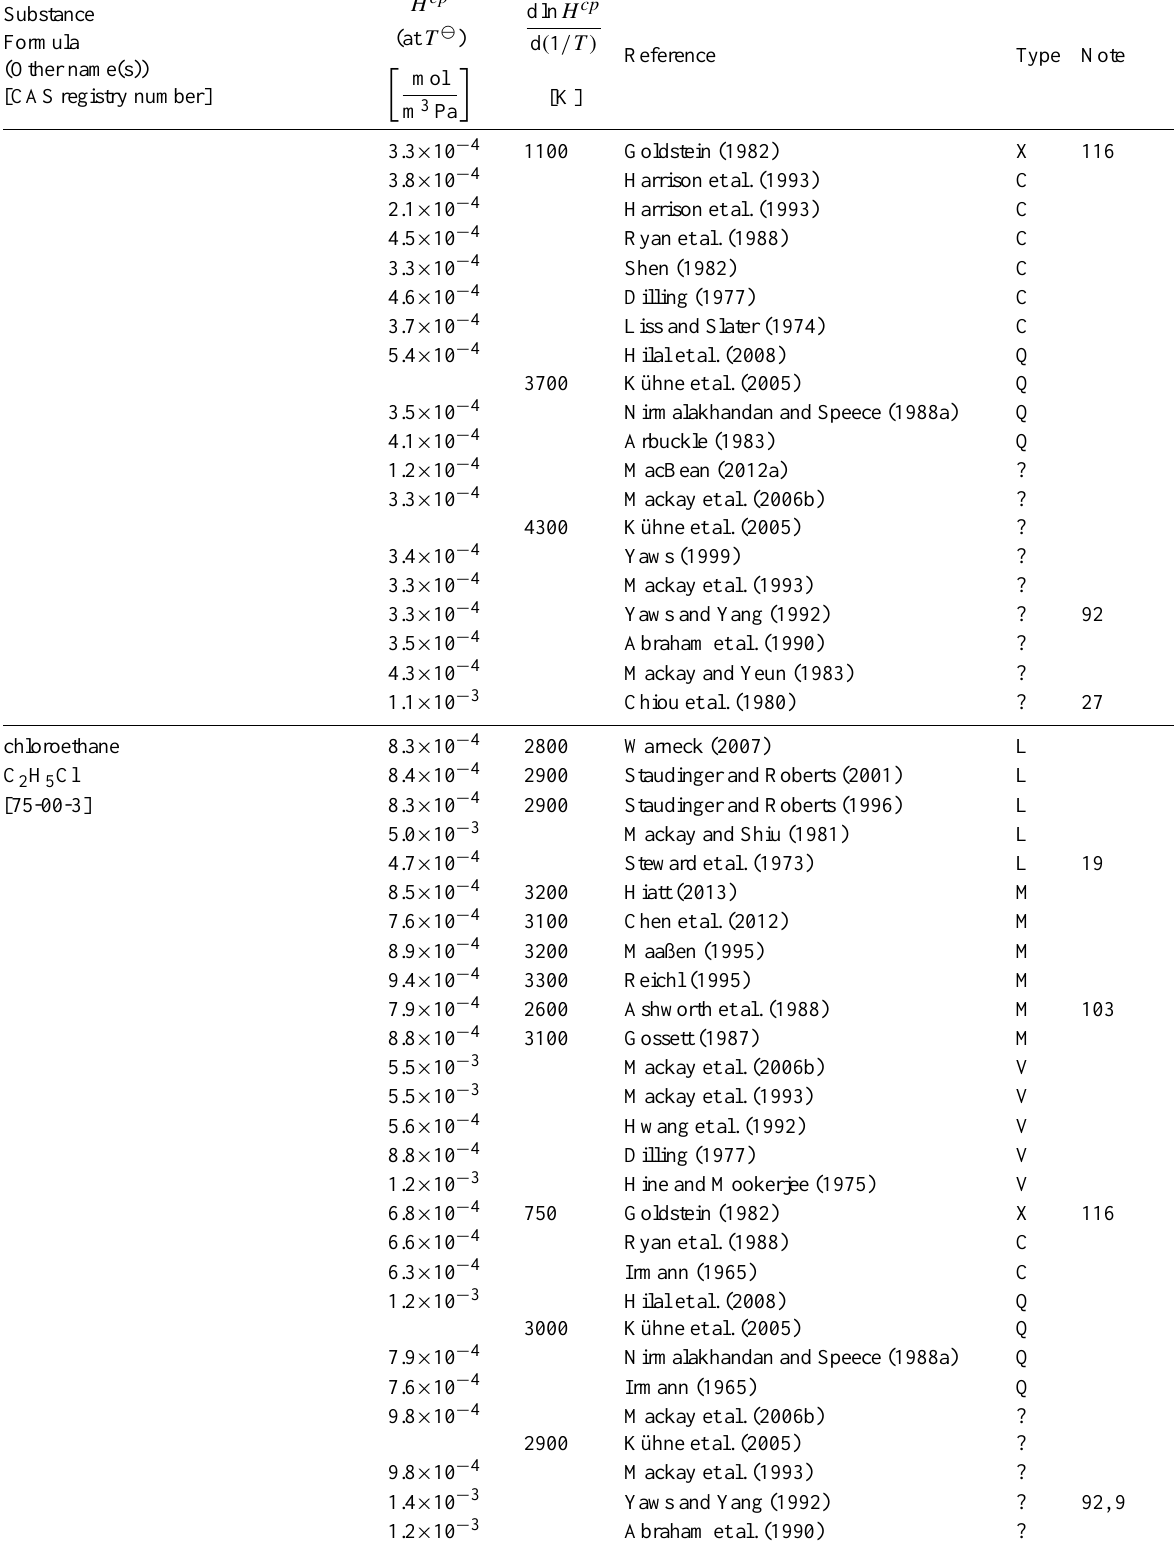
Table 6: Henry’s law constants for water as solvent